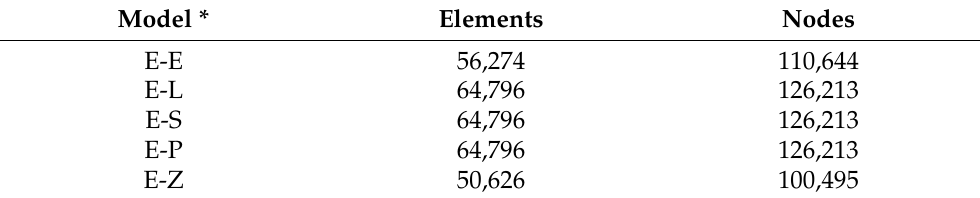
Table 2. The number of nodes and elements in the models.